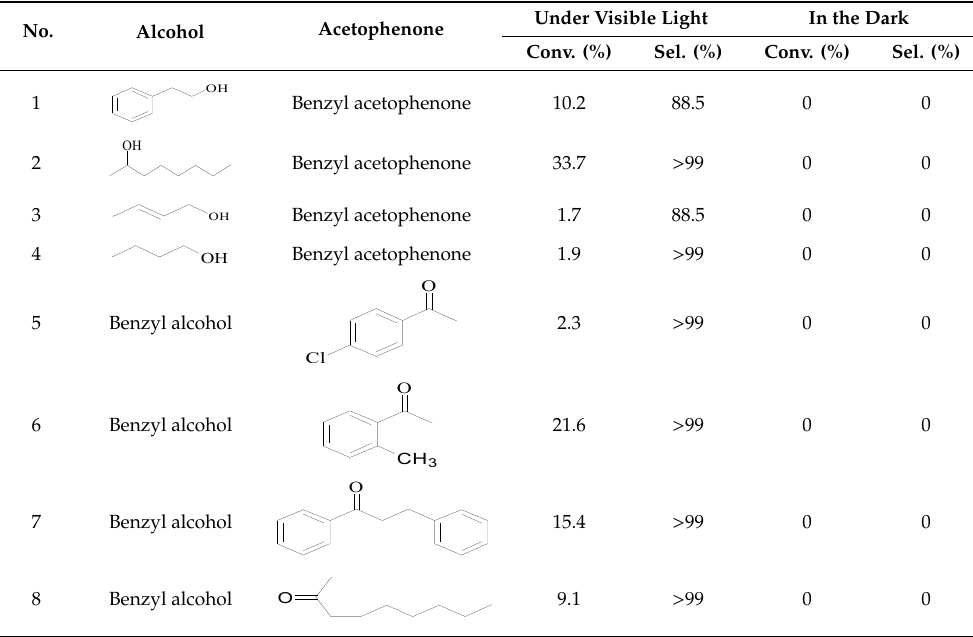
Table 8. Effect of the different alcohol and acetophenone derivatives on the reaction of benzyl alcohol and acetophenone.